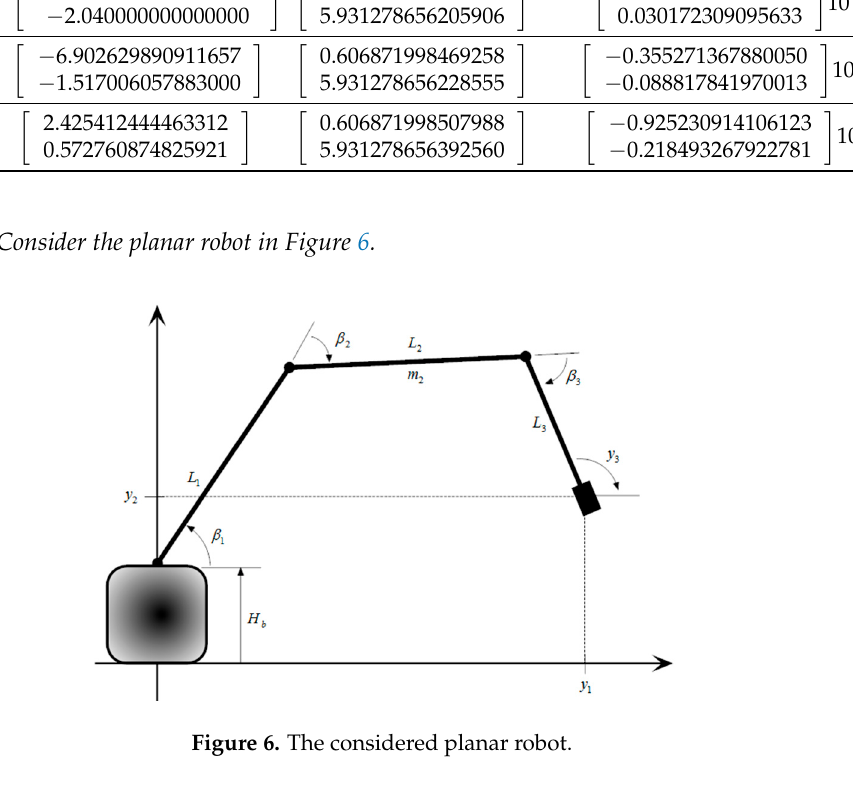
Table 1. Values of ˆ v and c ( ˆ v ) for several v 0 .